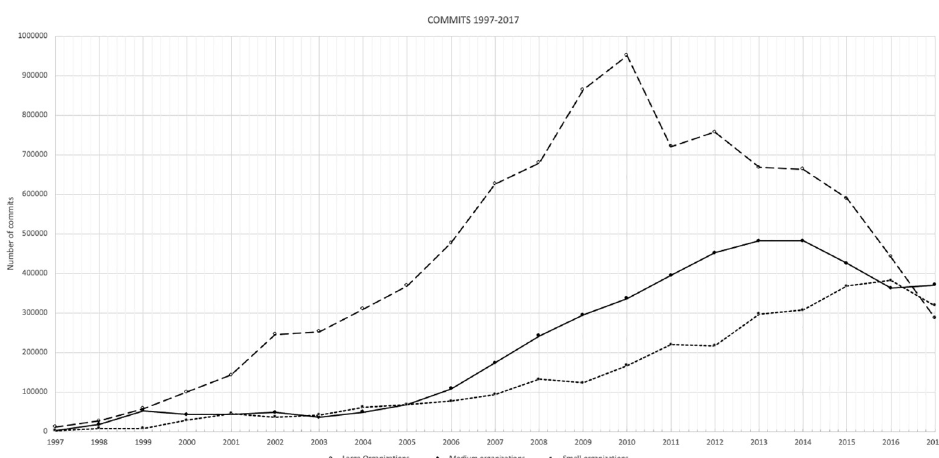
Fig 2. Commits analysis in FOSS organizations 1997–2017.